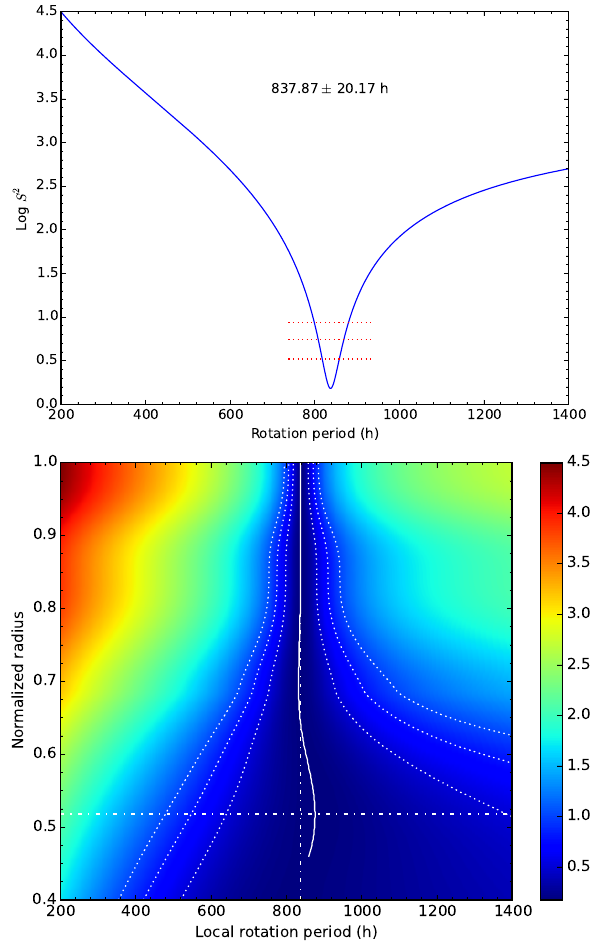
Figure 9. Top panel: Result of the optimization procedure under the hypothesis that PG 1219+534 rotates slowly and rigidly. This shows the behavior of the merit function S 2 in terms of the assumed rota- tion period. The dotted horizontal lines correspond, from bottom to top, to the 1-, 2-, and 3- σ limits. Bottom panel: Result for solid- body rotation using a variable step rotation law. This is a contour map indicating the behavior of the 2D merit function S 2 as a func- tion of depth (expressed in fractional radius) and in terms of the rotation period of the inner region of our two-zone approach. The solution is illustrated by the nearly vertical white curve and the dot- ted white curves depicting its associated 1-, 2-, and 3- σ contours. These contours diverge out at large depths which indicates that the rotationally split p -modes available in the present case lose their capacity to measure the local rotation rate there. The horizontal dot- dashed line indicates the layer above which there is 1% of the mass of the